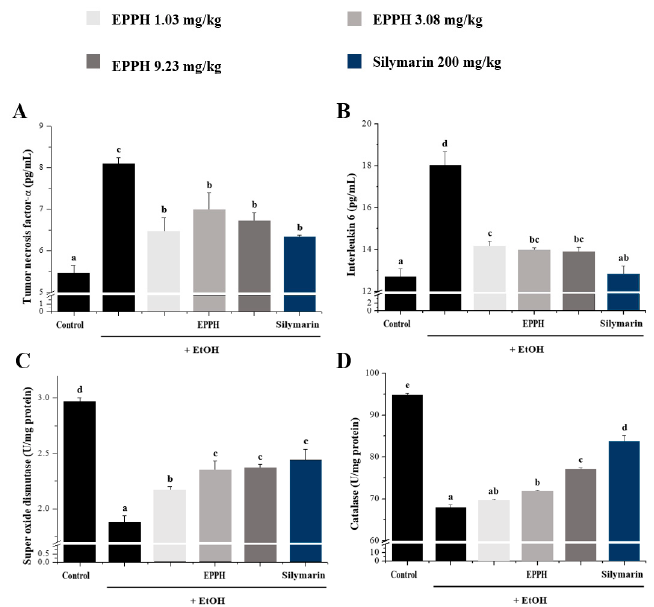
Figure 4. The effect of EPPH on inflammatory markers and lipid metabolism-related markers. Serum levels of ( A ) TNF- α , ( B ) IL-6, ( C ) SOD, and ( D ) CAT in EtOH-induced liver dysfunction in mice. Silymarin is a positive control. The data are expressed as the mean ± SD ( n = 10), and different letters (d > c > b > a) indicate a significant difference at p < 0.05, as determined by Duncan’s multiple-range test.